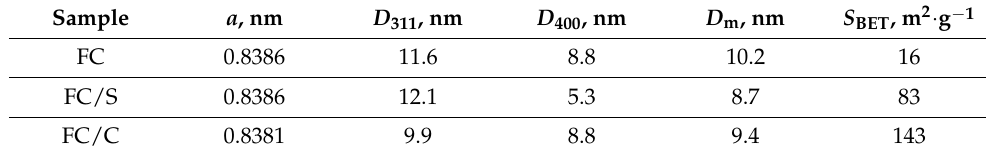
Table 1. Synthesized materials